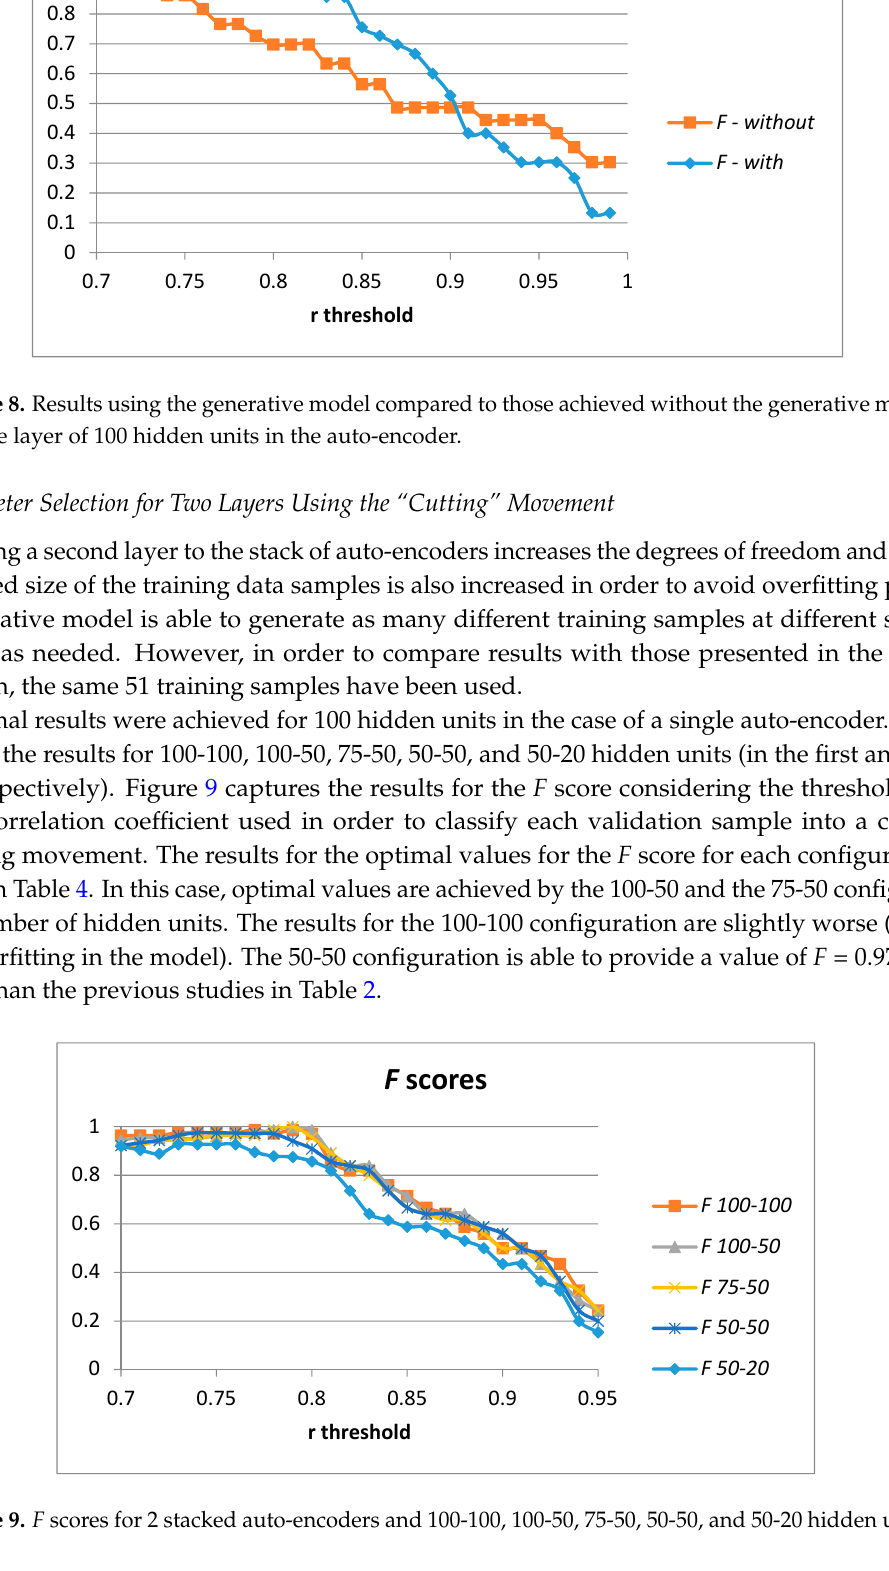
Figure 9. F scores for 2 stacked auto-encoders and 100-100, 100-50, 75-50, 50-50, and 50-20 hidden units.